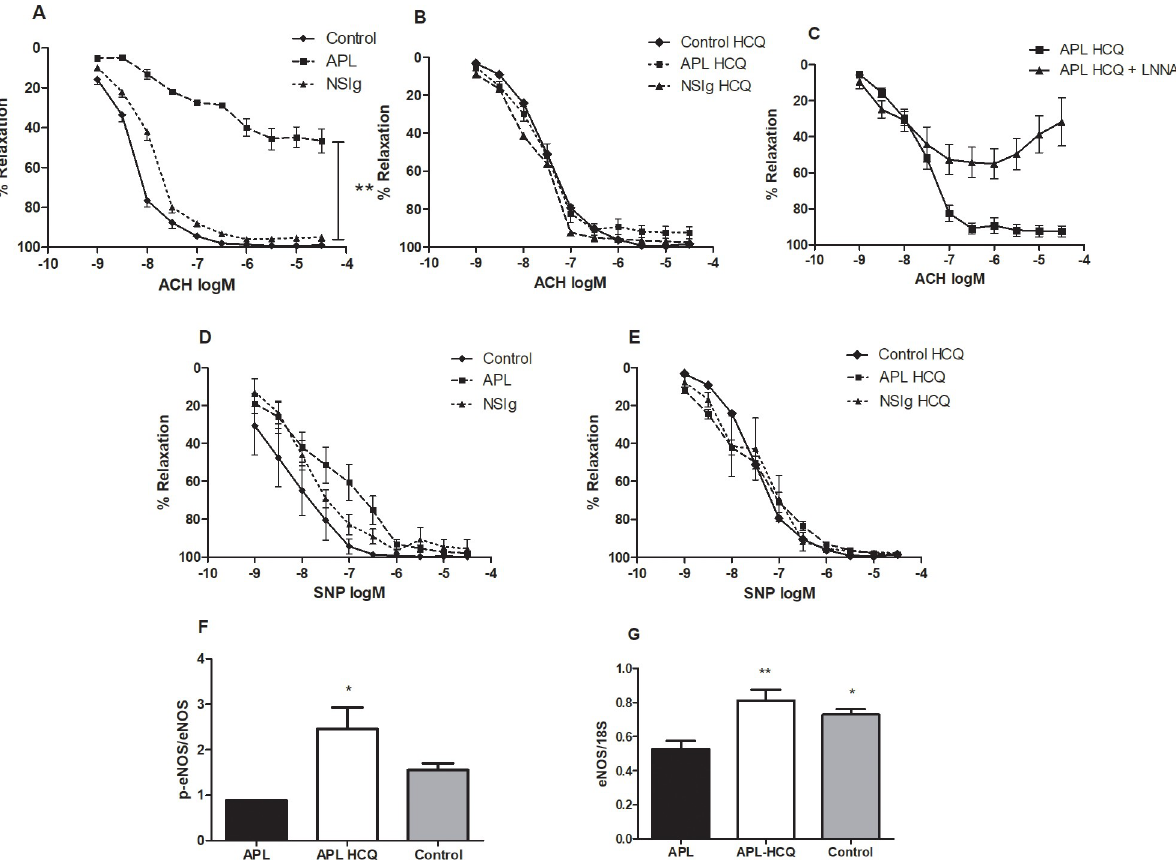
Fig 4. Effect of antiphospholipid antibodies and hydroxychloroquine on the relaxing responses to acetylcholine and on eNOS. (A,D) Endothelial function of mesenteric arteries was assessed seven days after the injection in control animals (full lines) and in aPL-IgG mice either untreated (dotted lines) or treated with HCQ (dashed lines) Relaxation responses to ACH and SNP in untreated mice or (B,E) HCQ-treated mice. (C) Effect of LNNA in the relaxing response to ACH, (F) Mouse mesenteric artery ratio of P-eNOS/eNOS measured by western blot. (G) Mouse aortic eNOS mRNA expression. Values are mean ± SEM � : P < 0 . 05 ; �� : P < 0 . 01 ��� : P < 0 . 001; n = 8 by groups in relaxation and ELISA experiments, n = 4 in western blot and qRT-PCR